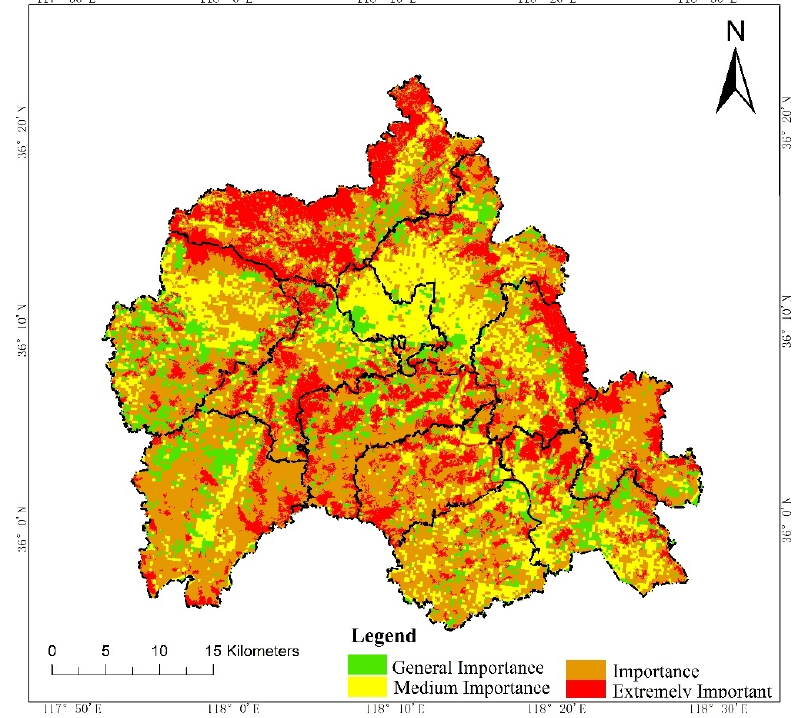
Figure 2. Evaluation of intensity of ecosystem service function.